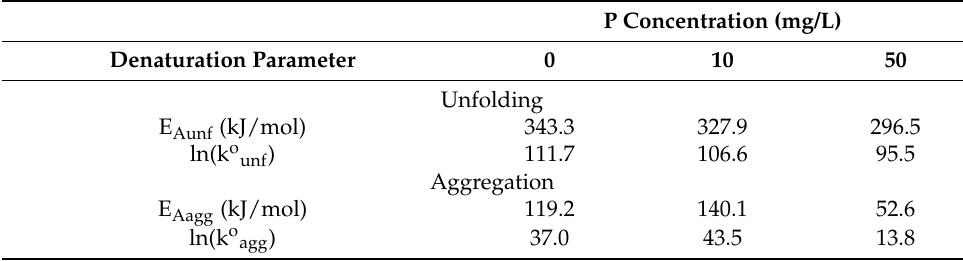
Table 1. Calculated denaturation parameters at various P